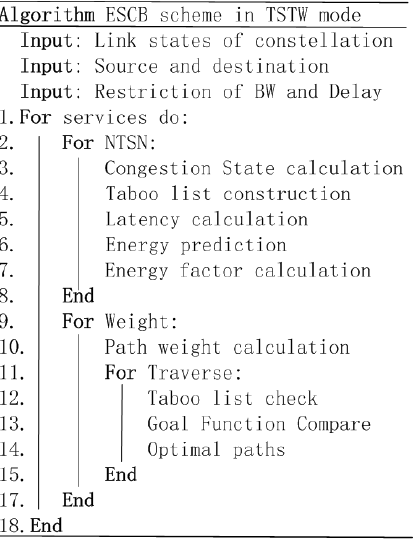
Figure 8. The pseudo code of path finding algorithm.